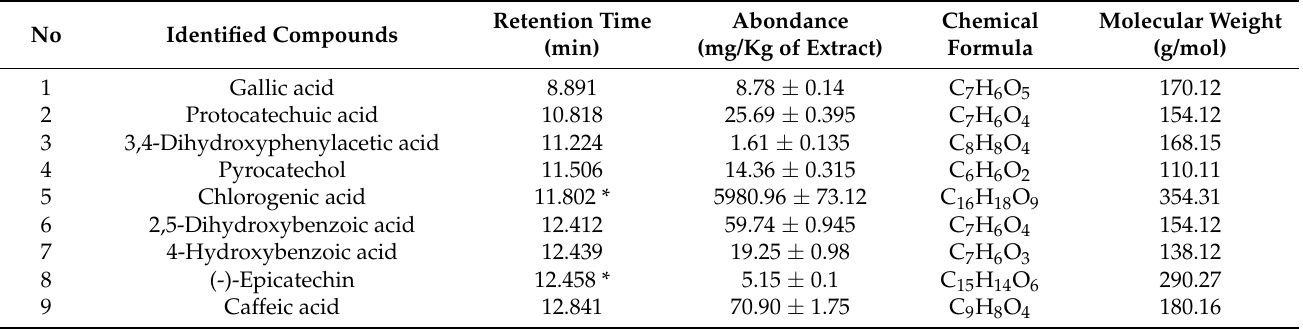
Table 1. Phytochemical profiling of D. flabellifolia methanol/water extract by using ESI–MS/ MS